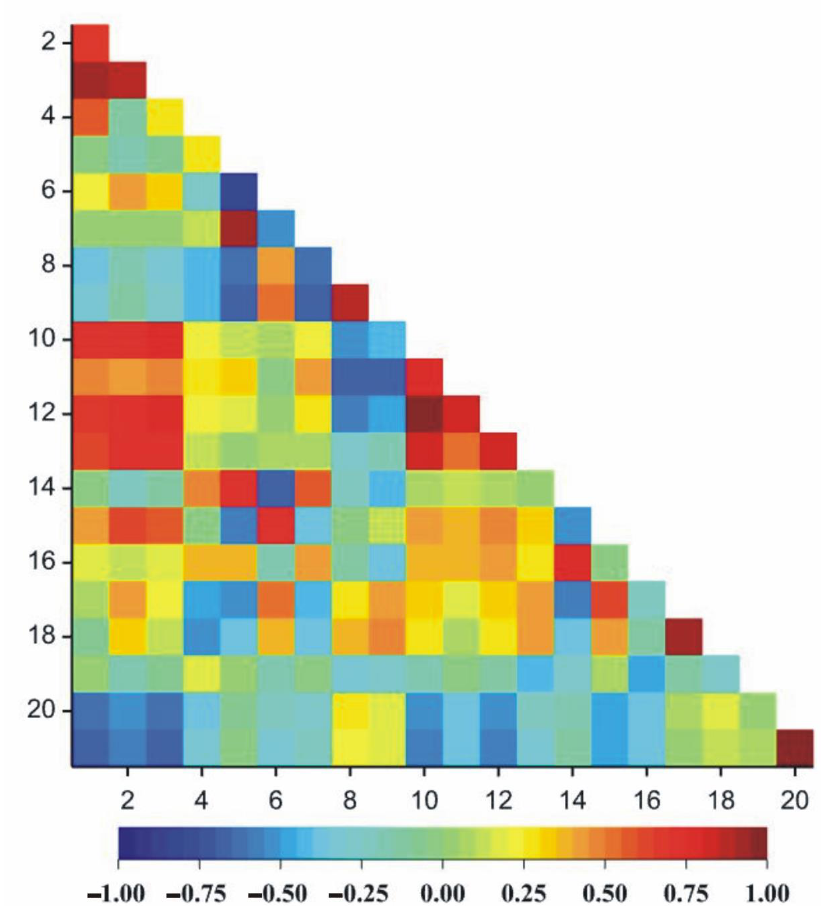
Figure 4. A heatmap showing correlation coefficients between all pairs of observed traits in drought treatment. [1 — chlorophyll a content (µg/g of d.w.) on the first day of drought; 2 — chlorophyll b content (µg/g of d.w.) on the first day of drought; 3 — chlorophyll a and chlorophyll b content (µg/g of d.w.) on the first day of drought; 4 — carotenoid content (µg/g of d.w.) on the first day of drought; 5 — Fv/Fm (maximum photochemical efficiency of PS II) on the first day of drought; 6 — area (pool size of electron acceptors from PSII) on the first day of drought; 7 — PI (overall performance index